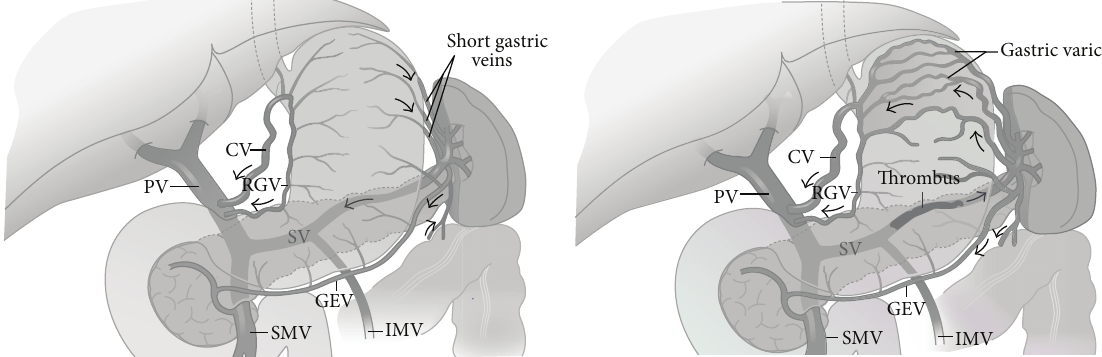
Figure 1: The effects of splenic vein thrombosis on normal venous anatomy. Note the gastric varices, dilatation of short gastric, and gastroepiploic (GEV) and coronary (CV) veins. The portal vein (PV), superior mesenteric vein (SMV), and inferior mesenteric vein (IMV) are patent. RGV: right gastric vein; SV: splenic vein [6].